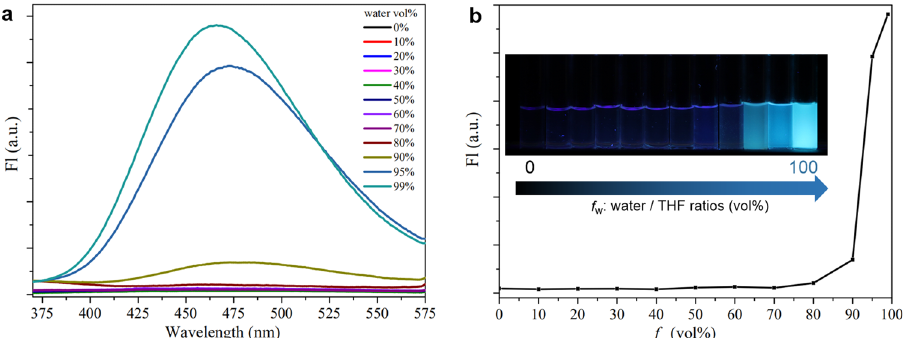
Fig. 3 AIE properties of HQTPE. a Fluorescence spectra of 100 μ M HQTPE in THF/Water mixtures with different water fractions excited at 300 nm. b Plot of the fl uorescence intensity of HQTPE at different THF/Water ratios. Inset shows the photograph of solutions of HQTPE at various THF/Water compositions upon exposing to UV